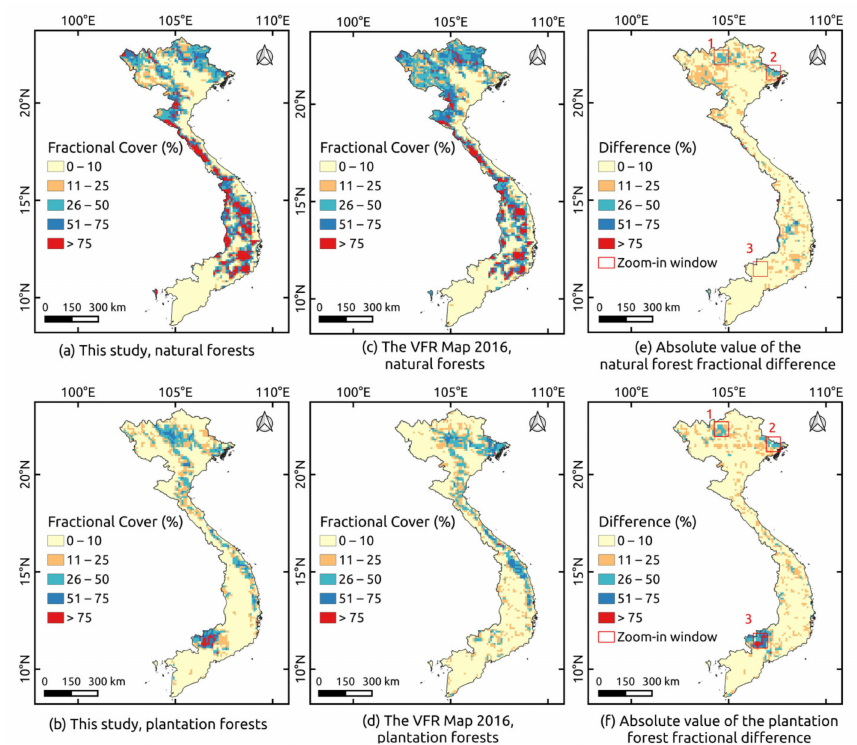
Figure 8. Comparison of the 10-km resolution forest fraction maps between this study and the Vietnam Forest Resource (VFR) Map 2016 and their forest fraction di ff erences. ( a ) Natural forest fractional cover map of this study; ( b ) Plantation forest fractional cover map of this study; ( c ) Natural forest fractional cover map of the VFR Map 2016; ( d ) Plantation forest fractional cover map of the VFR Map 2016; ( e ) Absolute value of the natural forest fractional di ff erence between this study’s map and the VFR Map 2016; ( f ) Absolute value of the plantation forest fractional di ff erence between this study’s map and the VFR Map 2016.